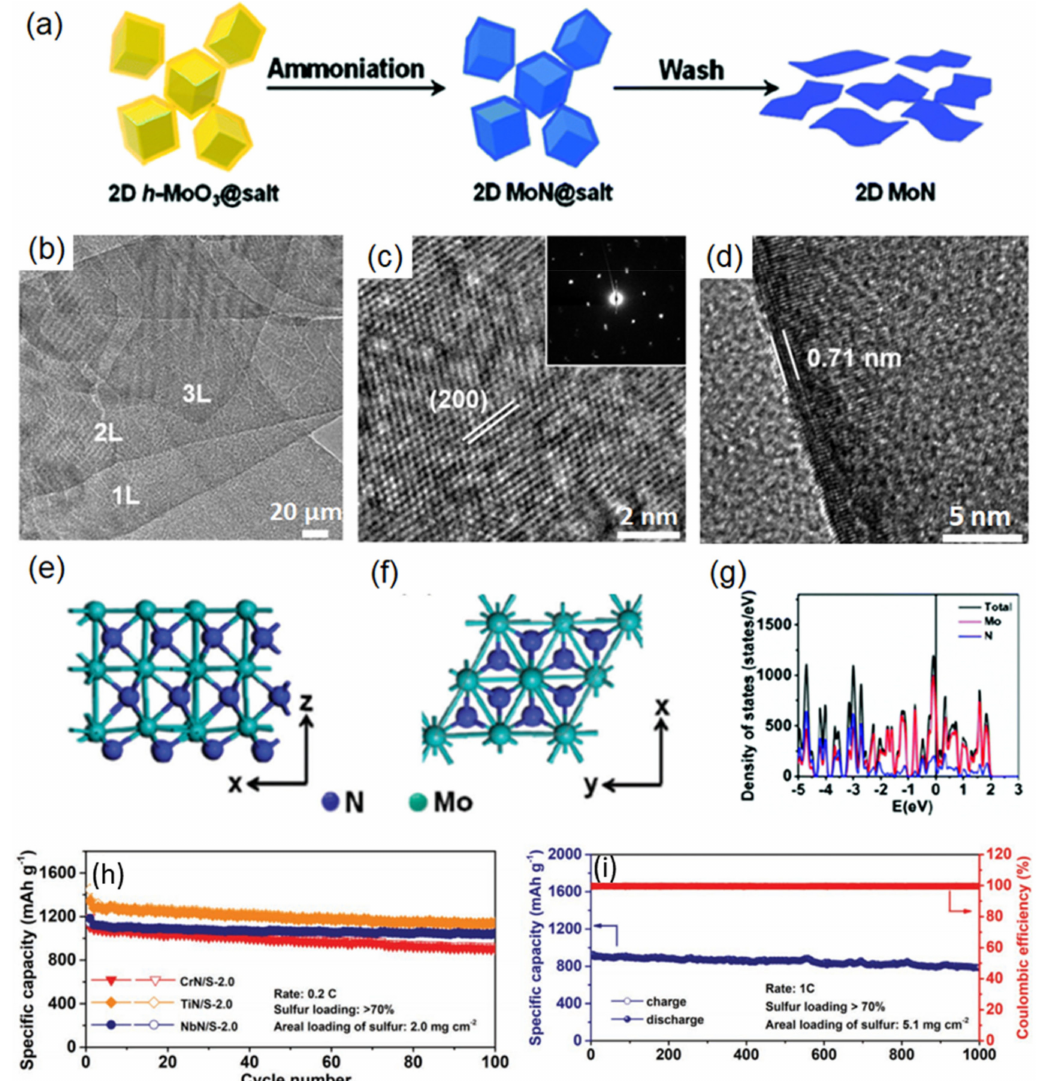
Figure 4. ( a ) Schematic illustration of 2D MoN synthesis. Side and top view images ( b , c ) of the atomic structure of 2D MoN. ( d ) Density of states of 2D MoN. ( e ) TEM image of overlapped single-layer MoN nanosheets. ( f ) HR-TEM shows that 2D MoN is single-crystalline with a hexagonal structure. The inset is a SAED that demonstrates the single-crystal structure of 2D MoN. ( g ) Electron density of states (DOS) of 2D MoN. No bandgap was found in 2D MoN, implying its metallic character. Reprinted (adapted) from Reference [25], copyright (2017) American Chemical Society. ( h ) Cycling performance of Li–S cells with CrN/S, TiN/S, and NbN/S cathodes at 0.2 C for 100 cycles (1 C = 1674 mA g − 1 ). ( i ) Cycling performance of NbN/S-5.1 cathode at 1 C for 1000 cycles. Reprinted (adapted) from Reference [43], copyright (2019) John Wiley and